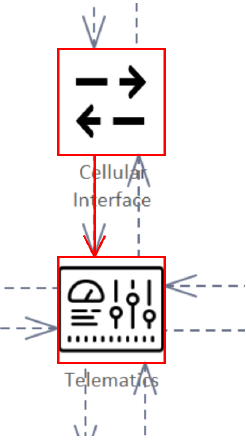
Figure 7. STRIDE per interaction example.